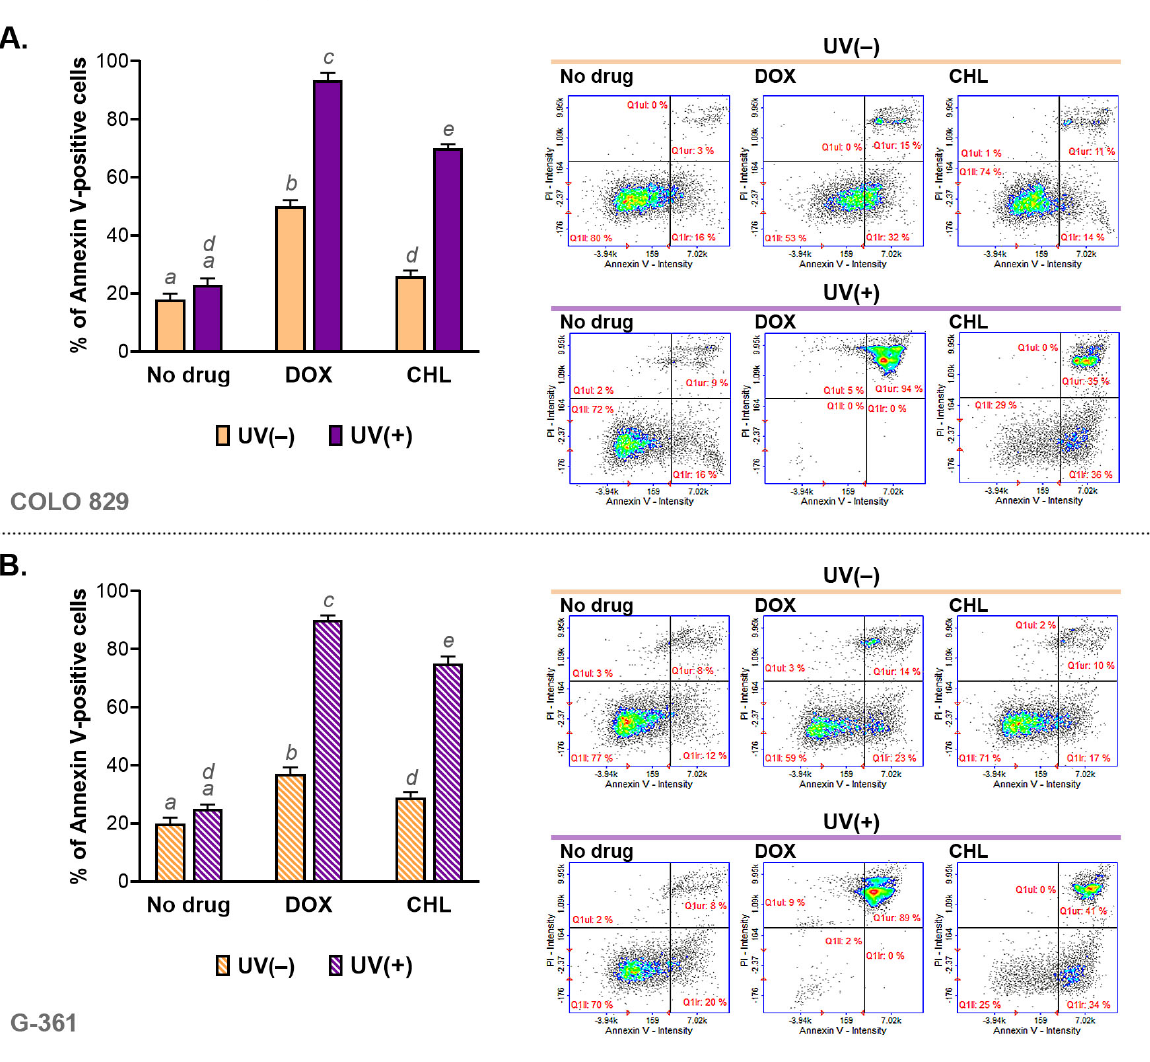
Figure 3. The cytometric analysis of annexin V in melanoma cells COLO 829 ( A ) and G-361 ( B ) incubated with doxycycline and chlortetracycline and irradiated with UVA. Bar graphs present mean values ± SD. Included scatter plots show representative results for the analysis of the tested cell populations. Using different letters to show statistical